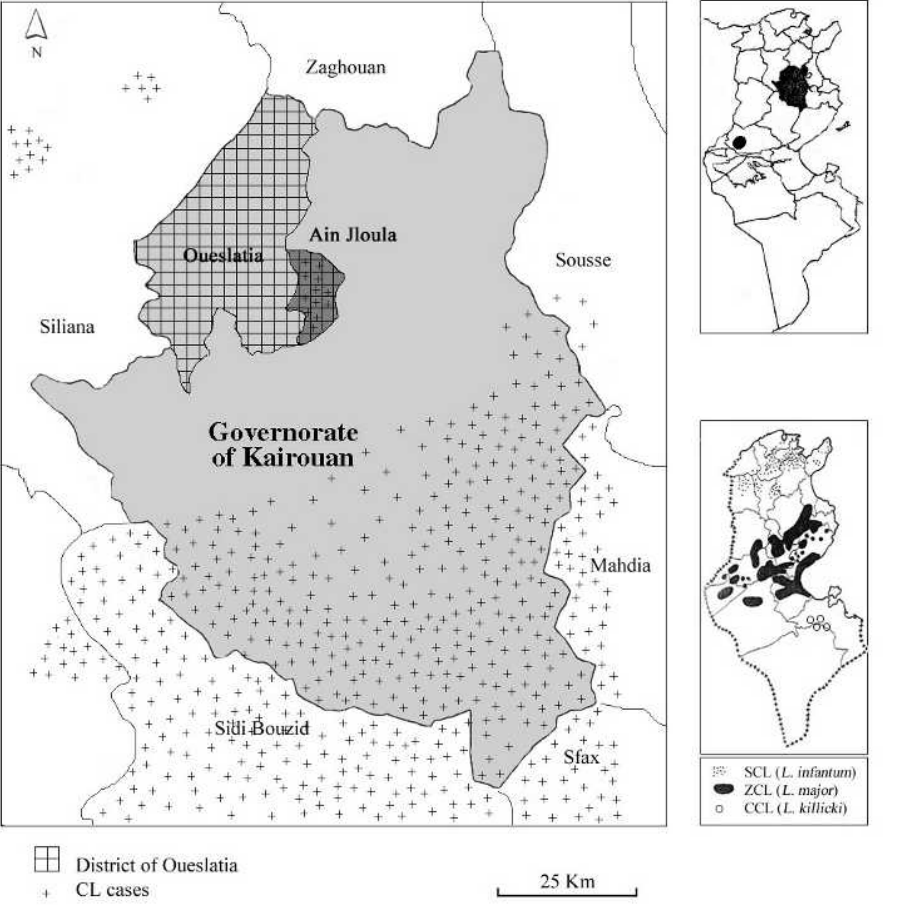
Fig. 1. – Geographical situations of the emerging focus of cutaneous leishmaniasis (CL) of Aïn Jloula (district of Oueslatia, Governorate of Kairouan, Central Tunisia) and the historic focus of zoonotic CL of Metlaoui. Two maps of Tunisia are on the right: the first, in the top right, shows the governorate of Kairouan and the city of Metlaoui shaded black; the second, below, gives details on the geographical distrib- ution of the three forms of CL encountered in Tunisia (Ben Ismail & Ben Rachid,